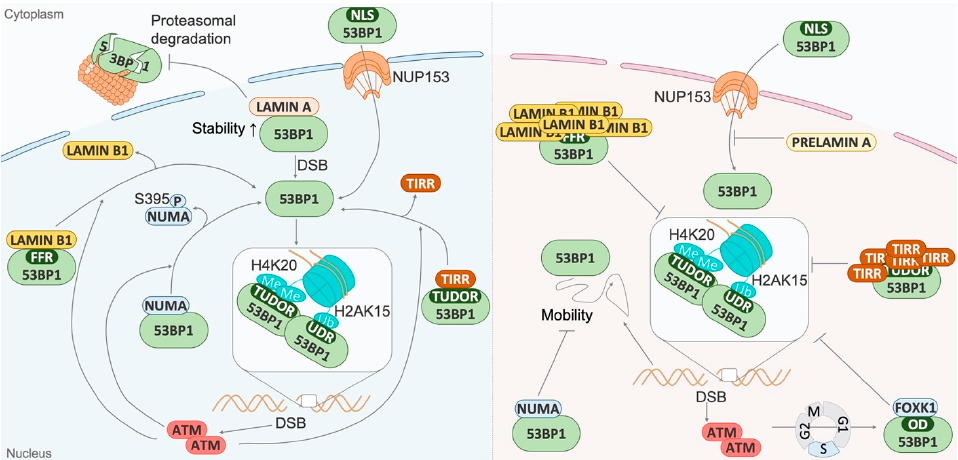
Figure 5. Factors participating in the regulation of 53BP1 recruitment to the chromatin, at a dis- tance from the DSB. Left panel: In the absence of DSBs, several factors such as TIRR and NuMA interact with 53BP1 to prevent its recruitment to chromatin by binding region essentials for 53BP1 recruitment. Upon DSBs, mechanisms regulated by ATM take place to dissociate these factors from 53BP1 and allow its recruitment to the damaged chromatin. Nuclear envelope proteins also play an important role in genome stability and 53BP1 regulation. Lamin A interacts with 53BP1 and increases its stability by preventing 53BP1 degradation by the proteasome. Furthermore, 53BP1 interacts with lamin B1 via its FFR domain, impeding its recruitment to DSBs. Upon DNA damage, an ATM-dependent dissociation occurs, thus enabling 53BP1 to be recruited to damaged chromatin. Right panel: In the absence of DNA damage, NuMA associates with 53BP1, reducing its mobility and its access to chromatin. Following DNA damage, ATM enhances the FOXK1–53BP1 interaction in the S phase, preventing 53BP1 recruitment to DSBs. On the other hand, prelamin A expression impedes 53BP1 importation to the nucleus via NUP153. 53BP1 interactors’ deregulation, such as TIRR or lamin B1 overexpression, also inhibits 53BP1 recruitment to damaged chromatin through its